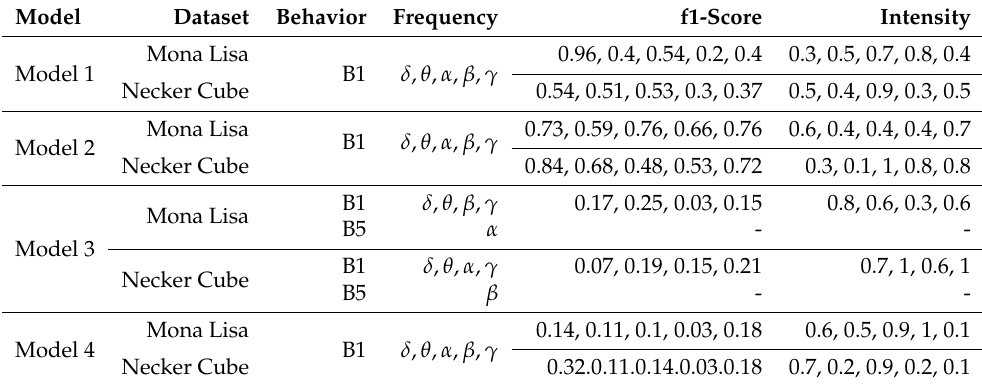
Table 12. The results of using the models with the Adadelta optimizer for intensity classification.